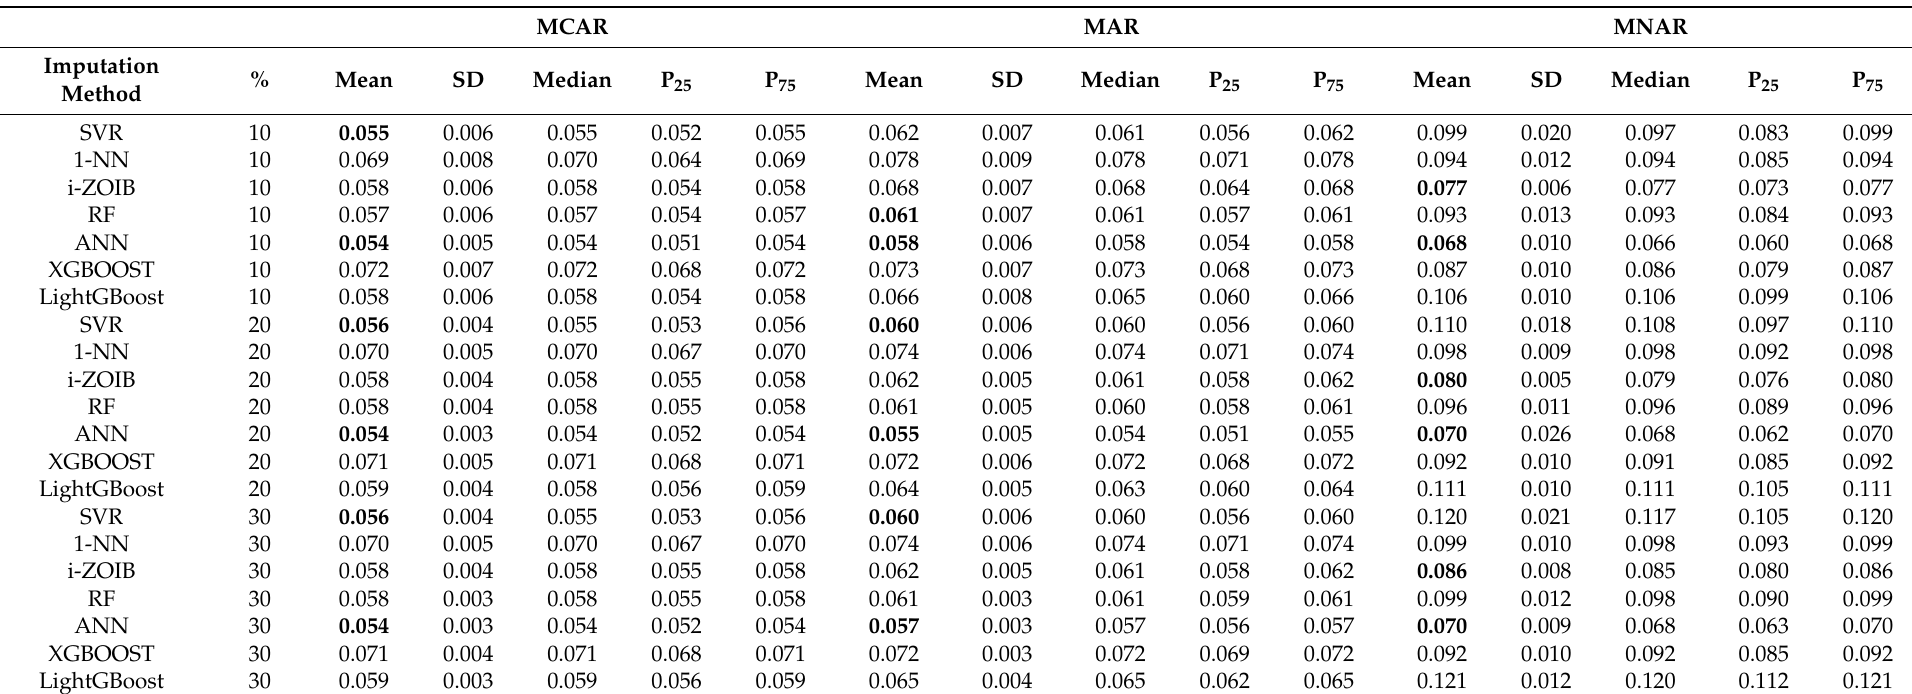
Table A1. Summary statistics of the MAE accuracy measure according to the missingness mechanisms, rates and imputation methods in the Scenario 1. MCAR MAR